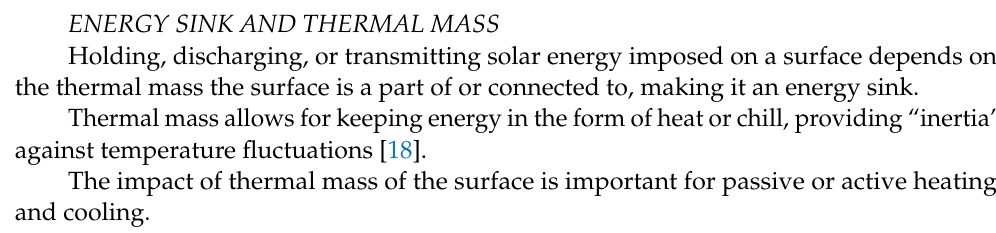
Figure 4. Obstruction of sunlight: ( a ) solar envelopes and ( b ) building